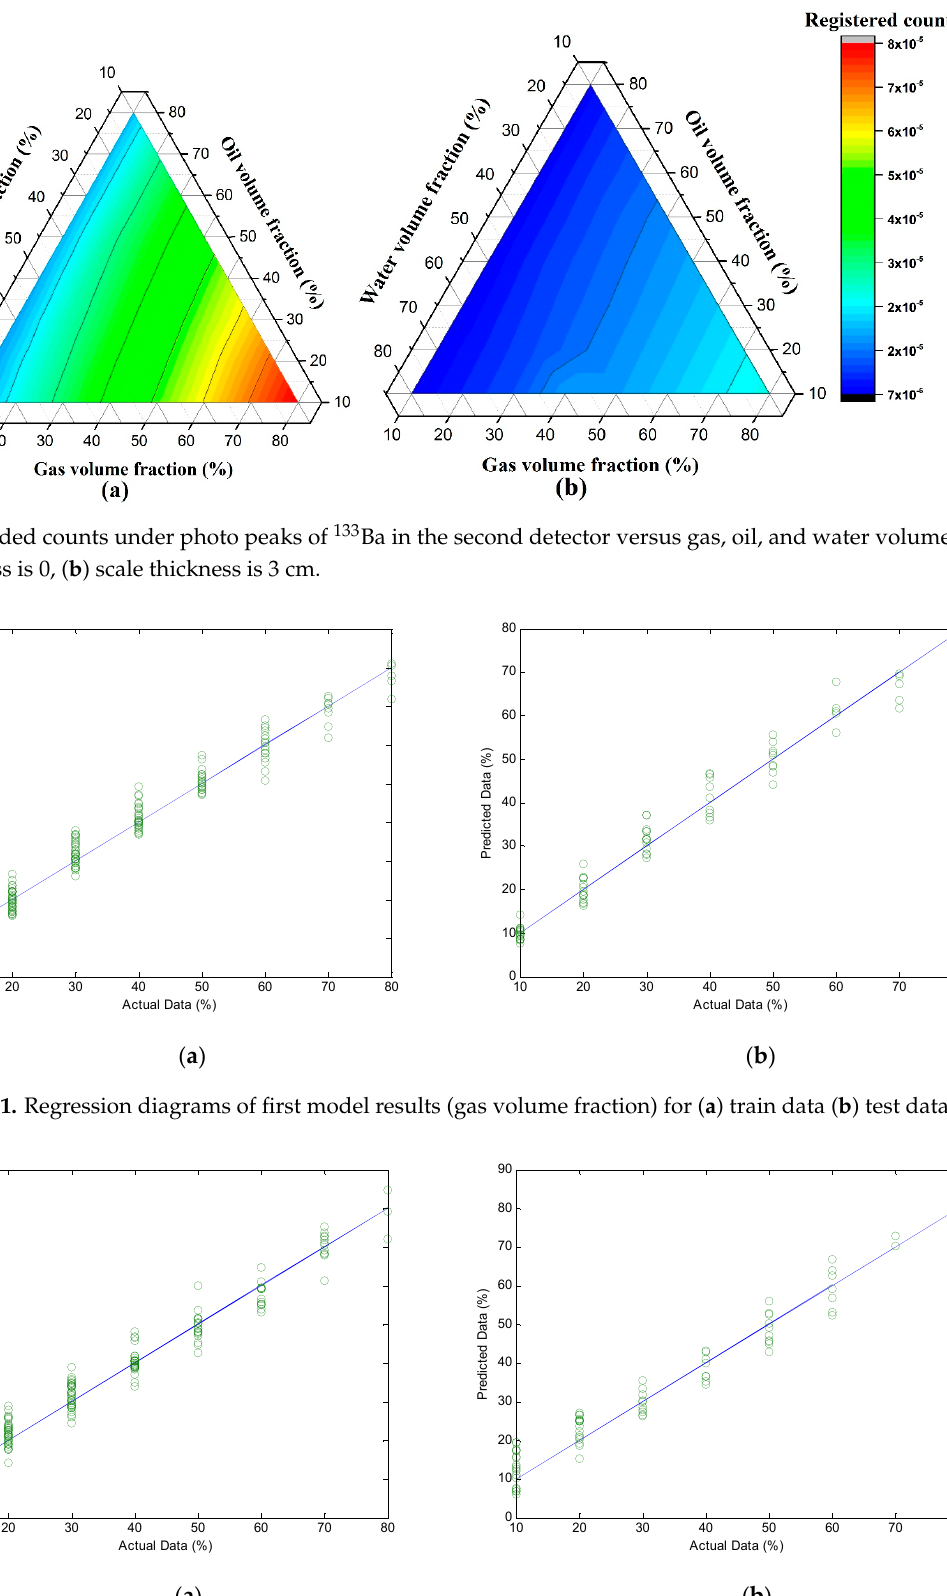
Figure 12. Regression diagrams of second model results (oil volume fraction) for ( a ) train data ( b ) test data. Table 1. The test data with predicted values.